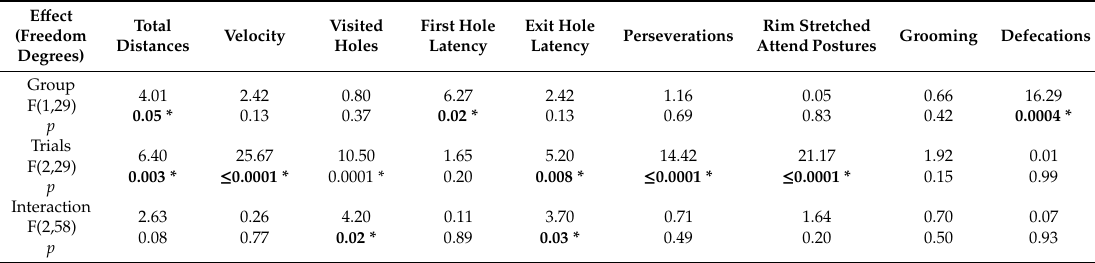
Figure 3. Behavior in the training trials. Total distances ( A ), velocity ( B ), visited holes ( C ), first hole exploration latency ( D ), exit hole exploration latency ( E ), perseverations (the mouse visited the same hole or at least two adjacent holes twice in a row) ( F ), rim stretched attend postures ( G ), grooming ( H ) and defecations ( I ) exhibited by animals injected with AM251 or vehicle (VHL). The data are presented as mean and standard errors. For each parameter, the values of trials 1-2 (T1-2), 3-4 (T3-4) and 5-6 (T5-6) were mediated and analyzed by two-way ANOVAs (group x trials). Significant group effect: @: p ≤ 0.05; @@@: p < 0.0005; significant Interaction : * p ≤ 0.05. Table 1. Statistical results of two-way ANOVAs on the behavioral parameters of the training trials. In bold * are reported significant